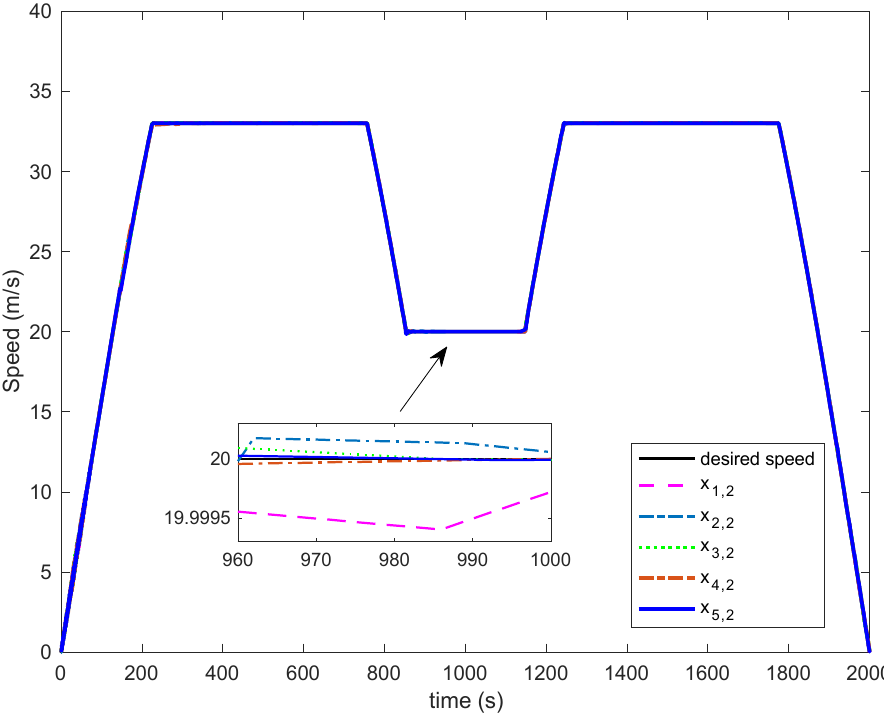
Figure 10. Desired speed and speed tracking curves for single-valued learning.